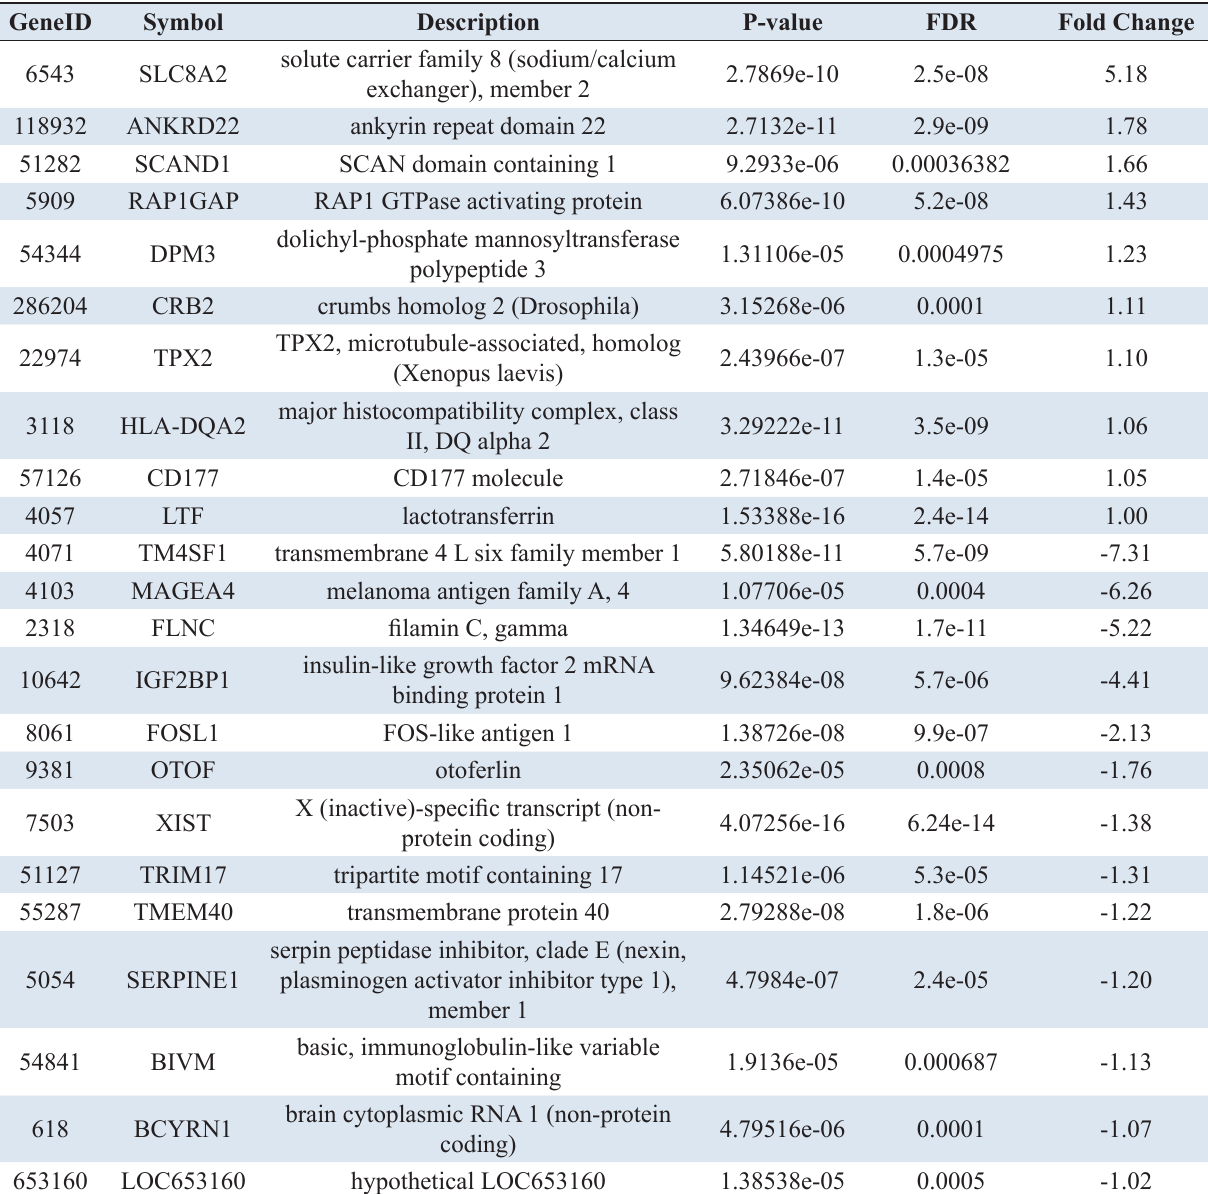
Table 1. Differentially expressed genes with statistically significant